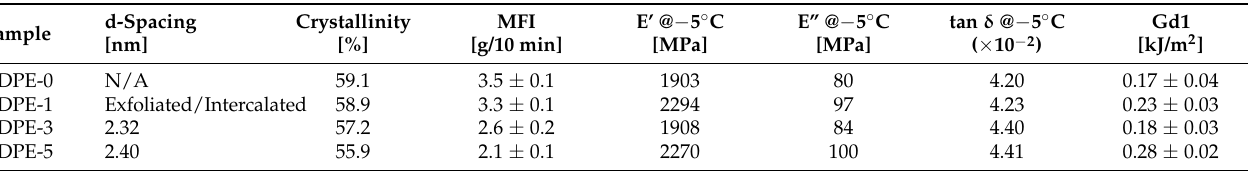
Figure 2. ( a ) The WAXD pattern and ( b ) storage and loss moduli for different HDPE–clay nanocom- posites (containing 0, 1, 3, and 5 wt% of nanoclay, respectively). Table 1. Nanocomposite d-spacing and relative crystallinity obtained from WAXD analysis, viscoelas- tic properties obtained using DMA, and G d 1 obtained using the HSDT